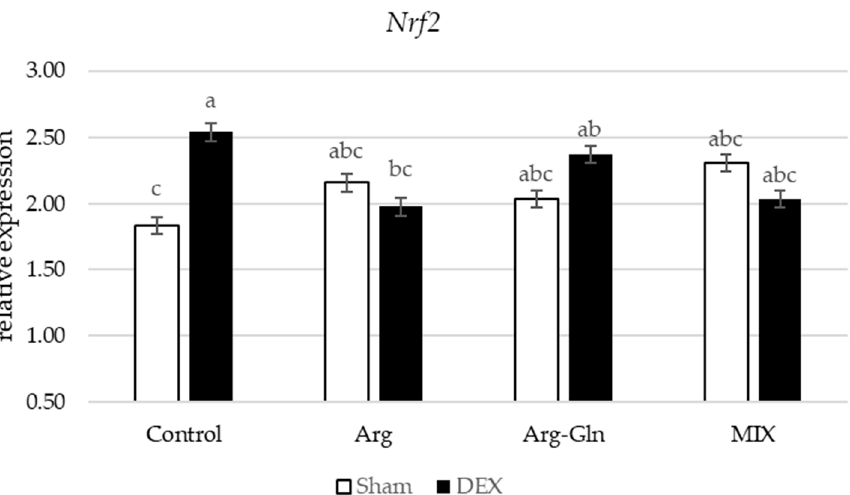
Figure 2. Interaction between diet and dexamethasone for relative mRNA expression of Nuclear factor-erythroid factor 2-related factor 2 ( Nrf2 ). abc Bars not sharing the same letter differ significantly ( p < 0.05). Error bars represent pooled standard error. DEX: Injected with dexamethasone; Sham: Injected with saline solution.